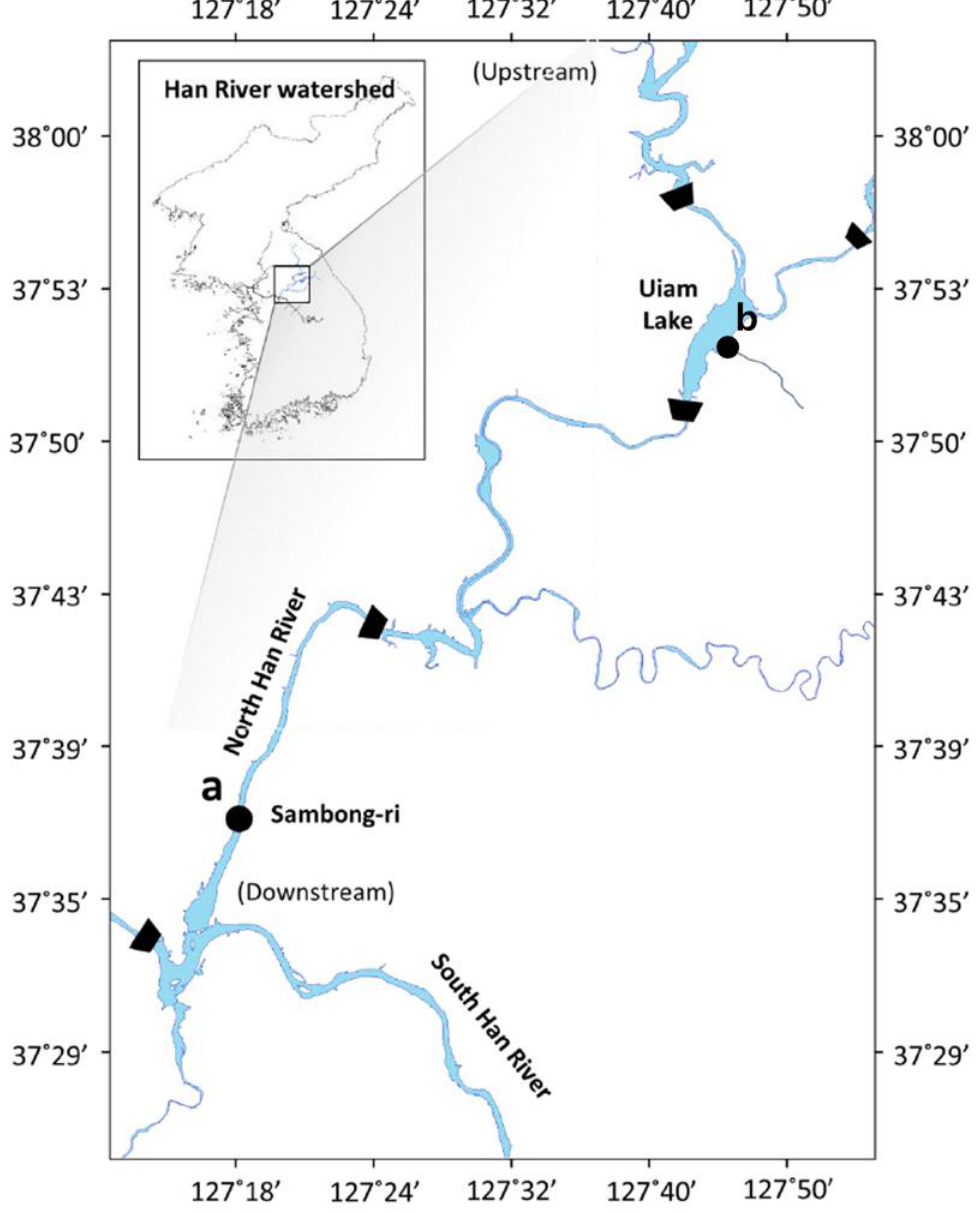
Figure 1. Locations of the North Han River watershed in South Korea and the sampling sites used in this study: ( a ) Downstream of the North Han River; ( b ) Junction with the Kong-ji